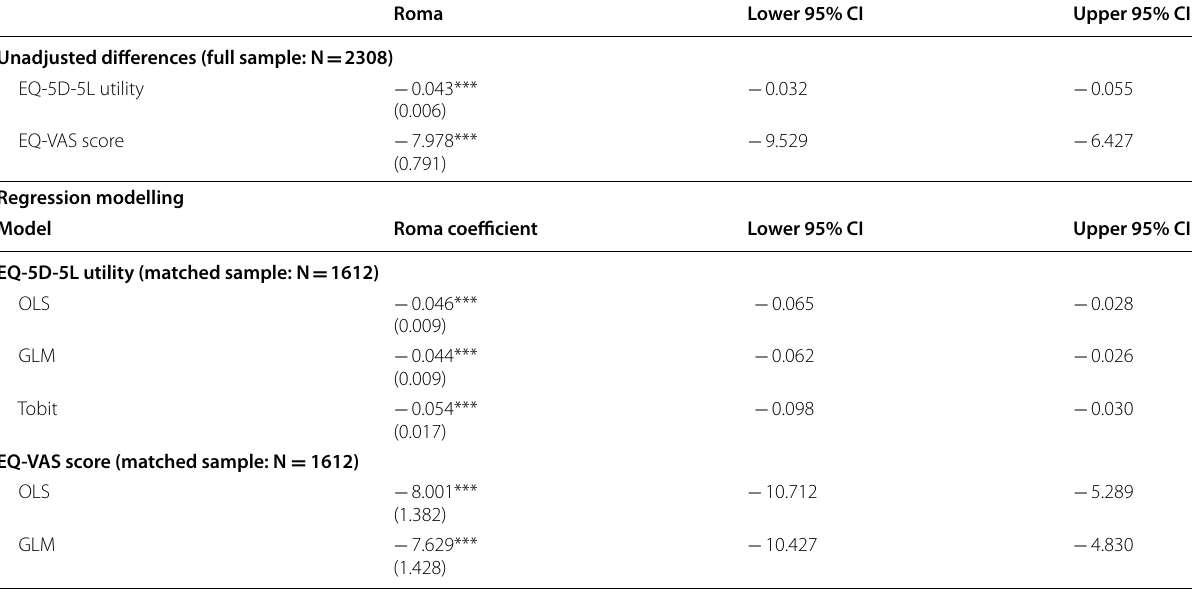
For regression models, coefficients are marginal effects from Ordinary Least Squares Models, Generalized Linear Models with a Gaussian Distribution and a Log Link Function and a Tobit Model right censored at 1. All models include CEM weights and are additionally adjusted for Age. Robust standard errors in parentheses ***p <